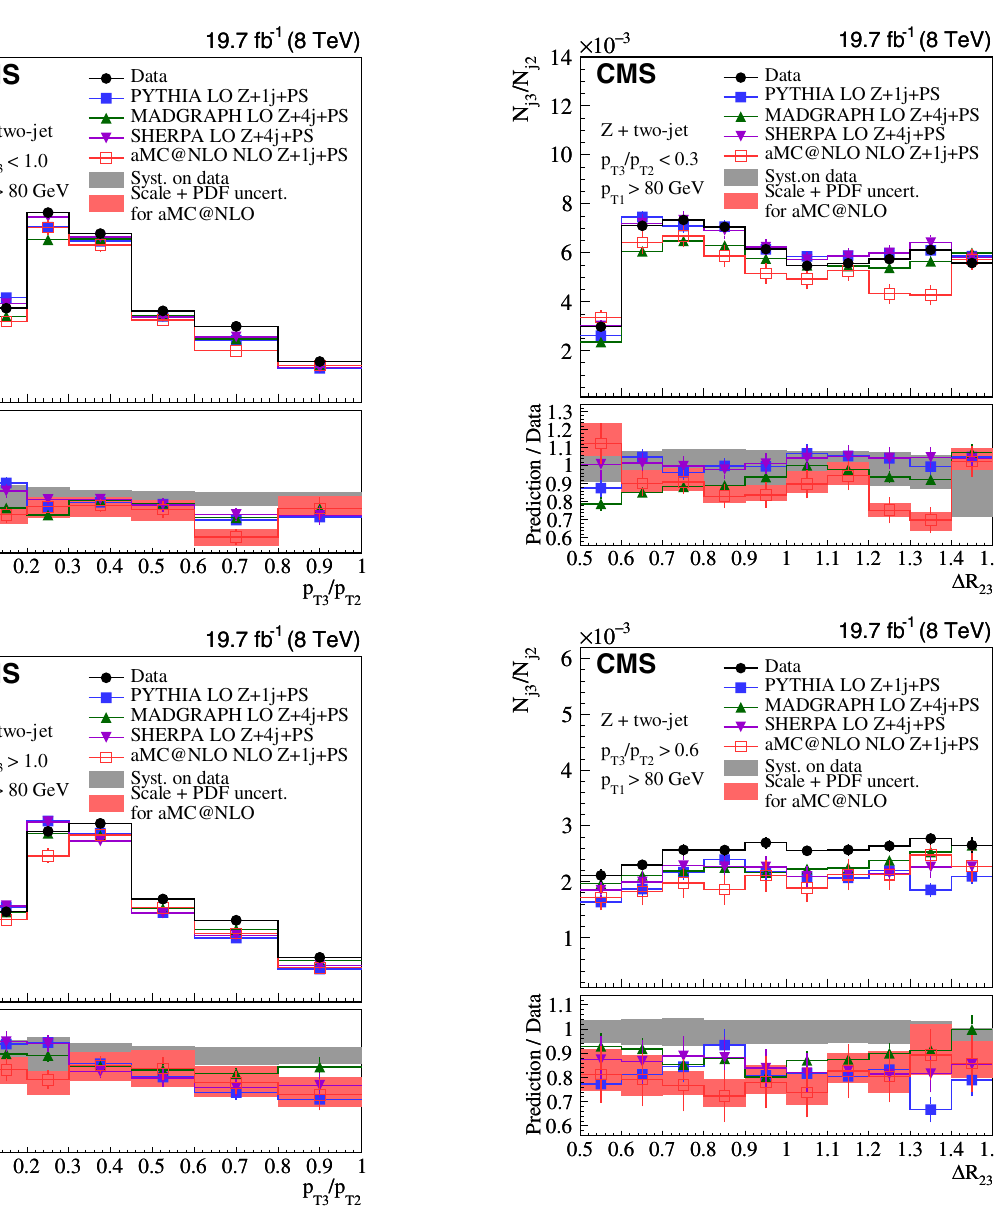
√ s = 8TeV compared to theory: (upper)